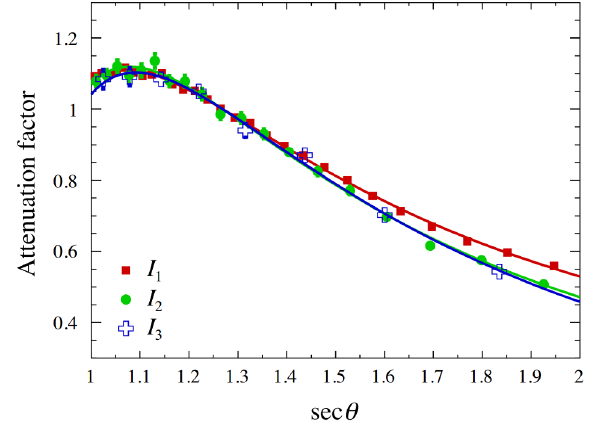
Figure 2. Attenuation curves of S (1000) as a function of sec θ for three di ff erent intensities corresponding to the following ener- gies: 3 × 10 18 eV (red), 8 × 10 18 eV (green) and 2 × 10 19 eV (blue). Details are presented in Ref.